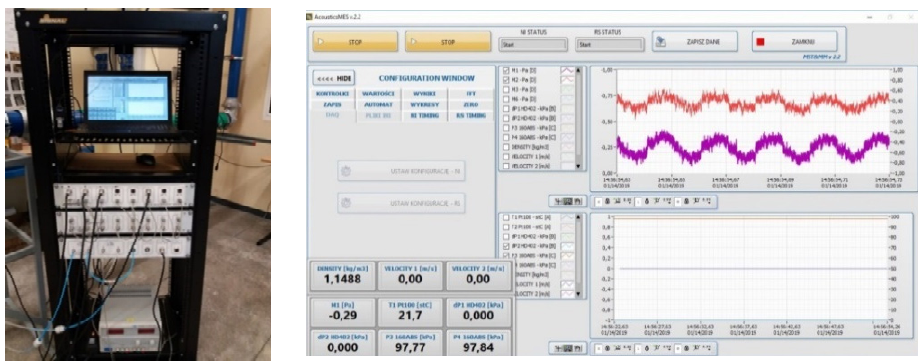
4 of 17 Figure 2. Scheme of the test stand and the air preparation system. Figure 3. Test stand. The main element of the air preparation system is the Roots DR124T blower with a maximum flow rate of 12.4 m 3 /min. It is powered by a 13.2 kW synchronous electric motor, and the maximum negative gauge pressure that it is possible to obtain is 50 kPa. It is directly connected to the 3.2 m 3 air tank. The air tank is also equipped with two control valves that control the mass flow rate in the main pipeline. The tank compensates for pressure fluctuations associated with the operation of the Roots blower.